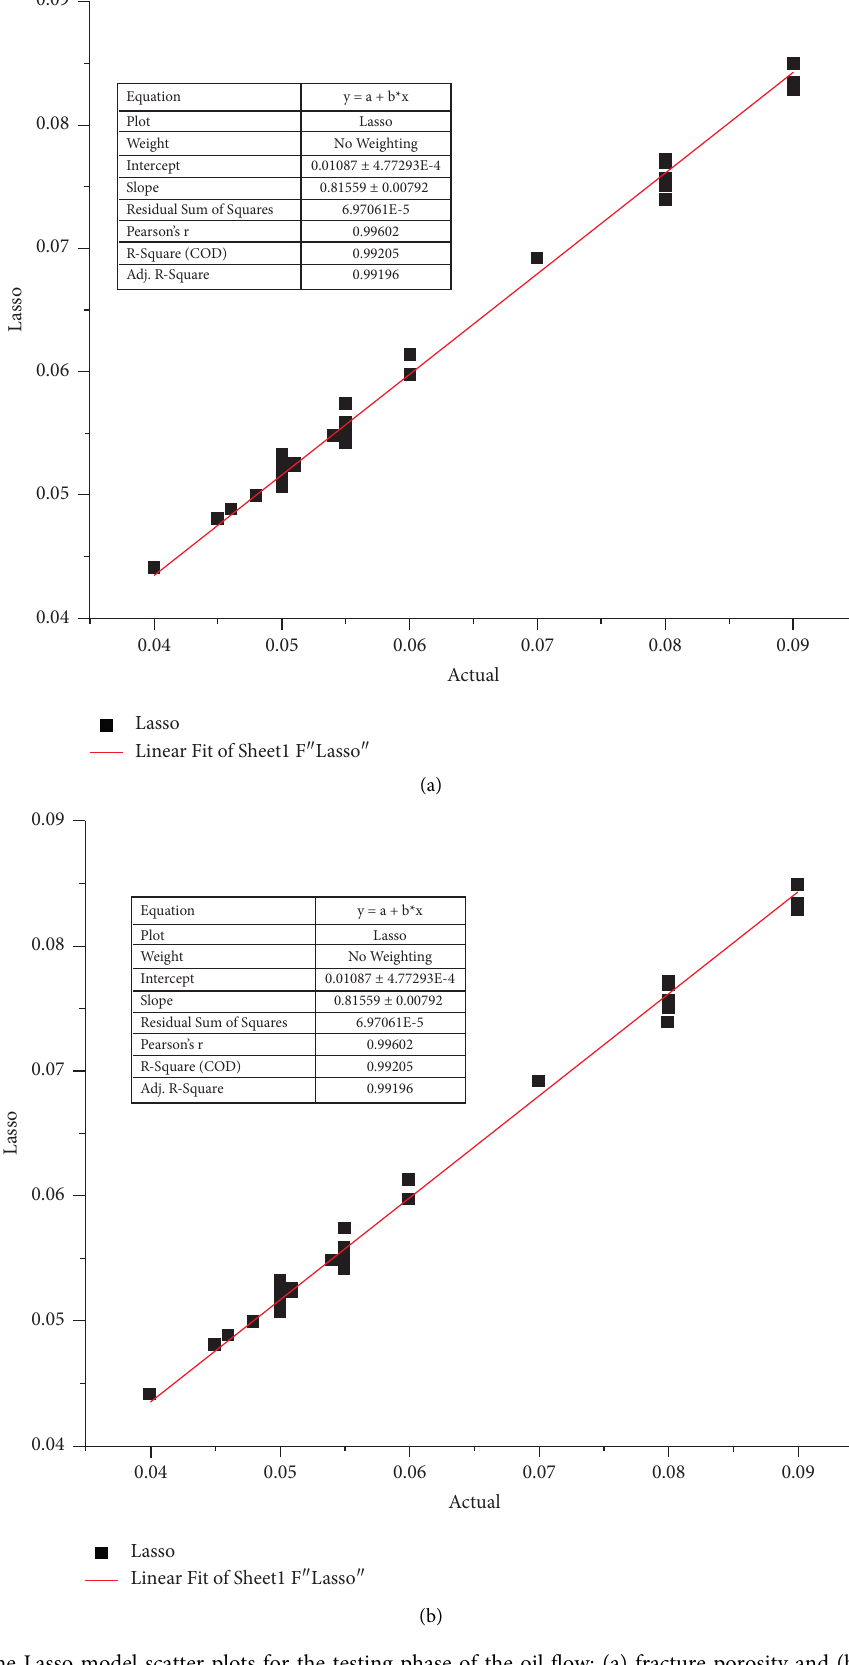
Figure 12: Te Lasso model scatter plots for the testing phase of the oil fow: (a) fracture porosity and (b) shape